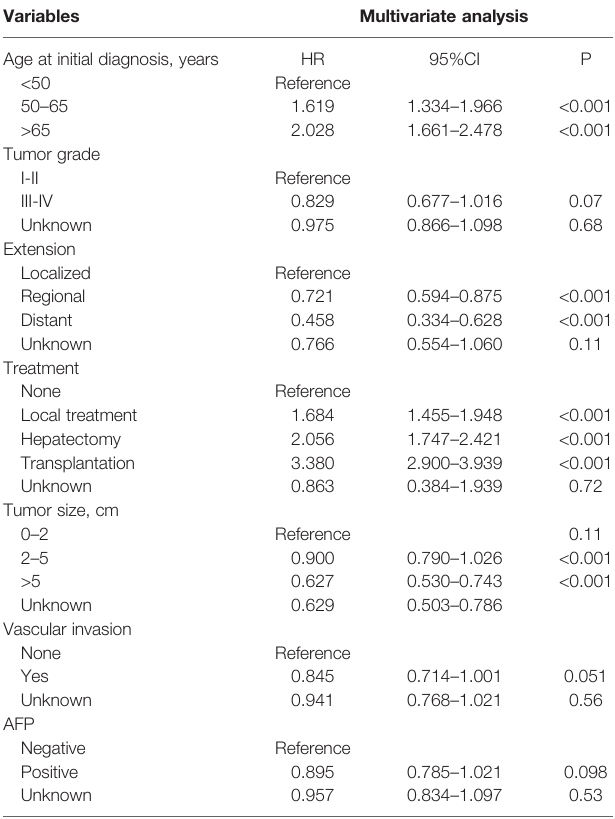
TABLE 2 | Risk factors associated with the development of SPMs for HCC patients after initial diagnosis. Variables Multivariate